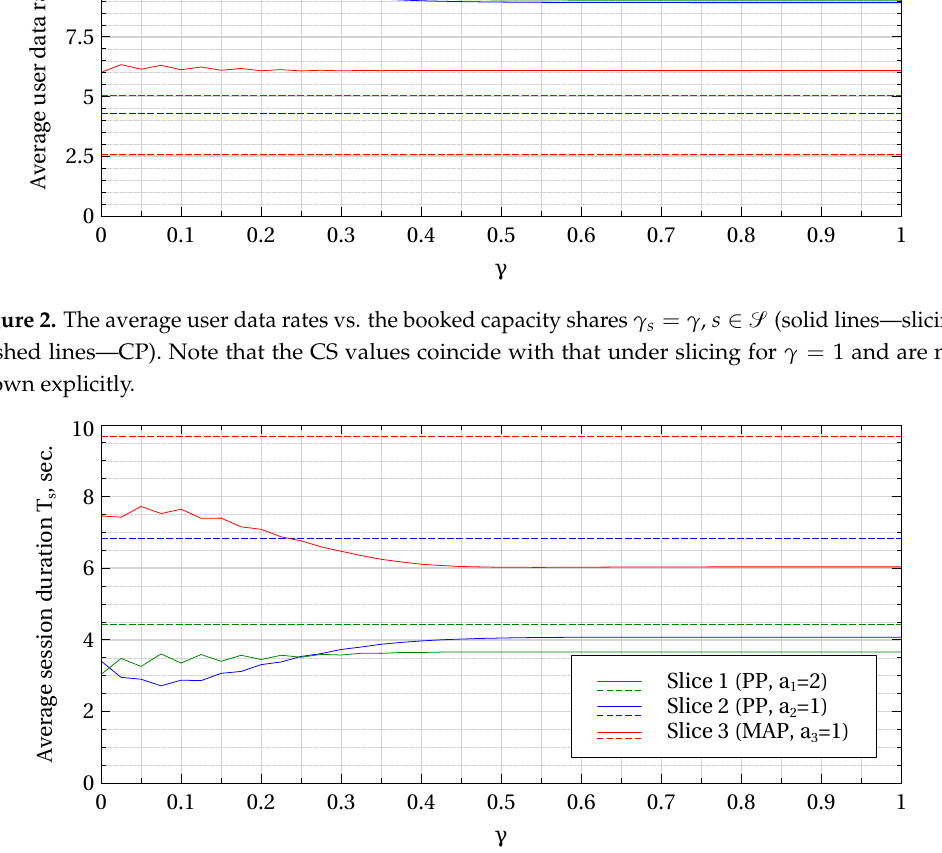
Figure 3. The average session duration vs. the booked capacity shares γ s = γ , s ∈ S (solid lines—slicing, dashed lines—CP). Note that the CS values coincide with that under slicing for γ = 1 and are not shown